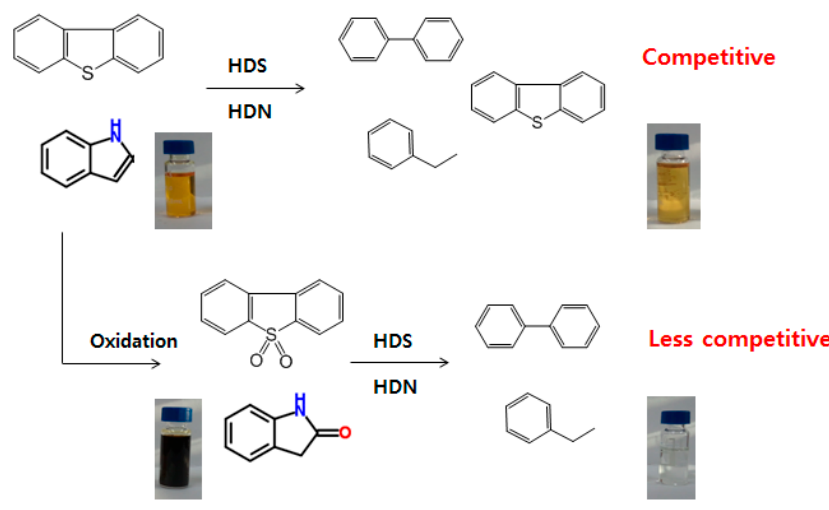
Figure 7. Proposed reaction pathways of HDS and OX ‐ HDS.